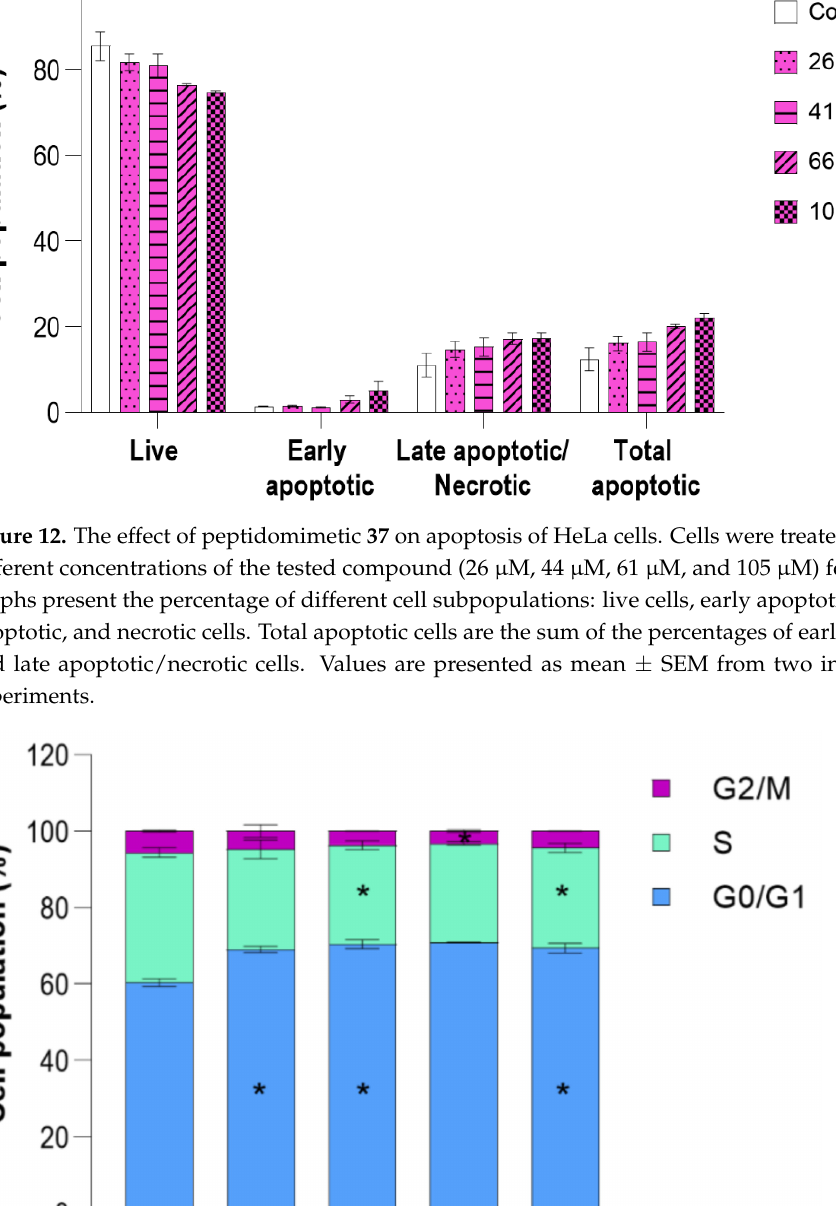
percentage of cells in the G2/M phase (* p < 0.05). These results, together with those shown in Figure 12, may indicate that compound 37 causes early apoptosis event as a results of cell cycle arresting. Because cell cycle regulation in mammalian cells is very complex, further studies should be performed to determine the exact mechanism underlying these effects.